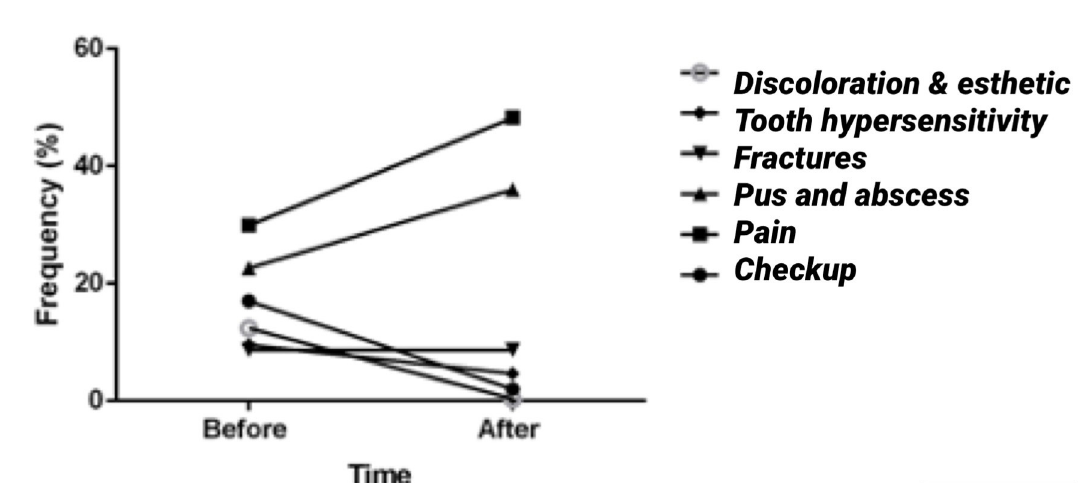
Fig 1. Changes in the chief complaints of patients after the COVID-19 pandemic emergence compared with before among a group of dental patients (n = 756) in Iran.